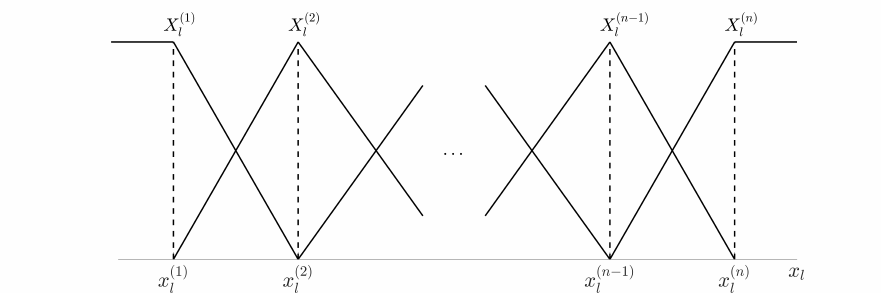
Figure 1. Input membership function x l .